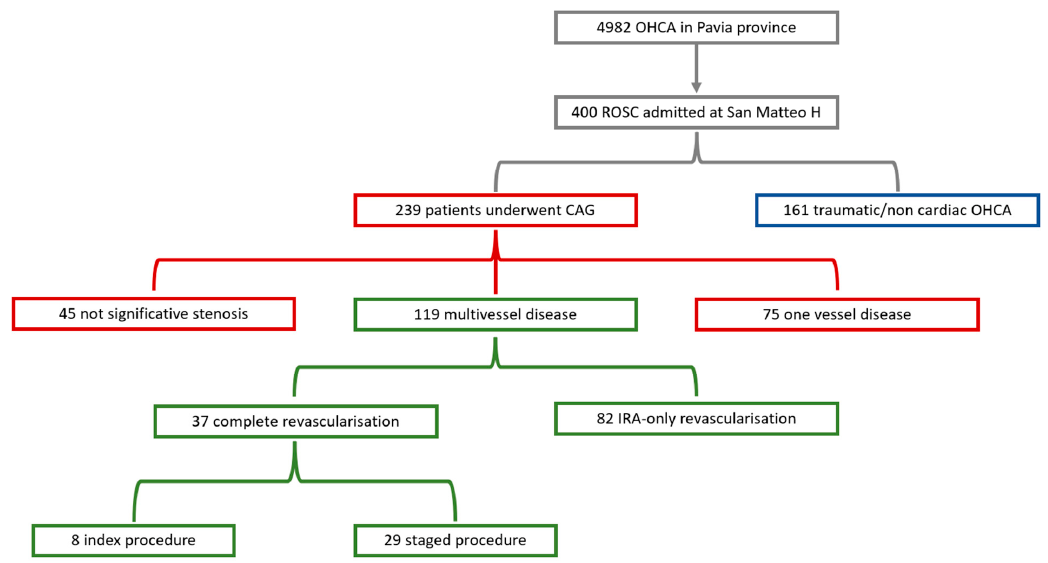
Figure 1. Flow-chart of the study.